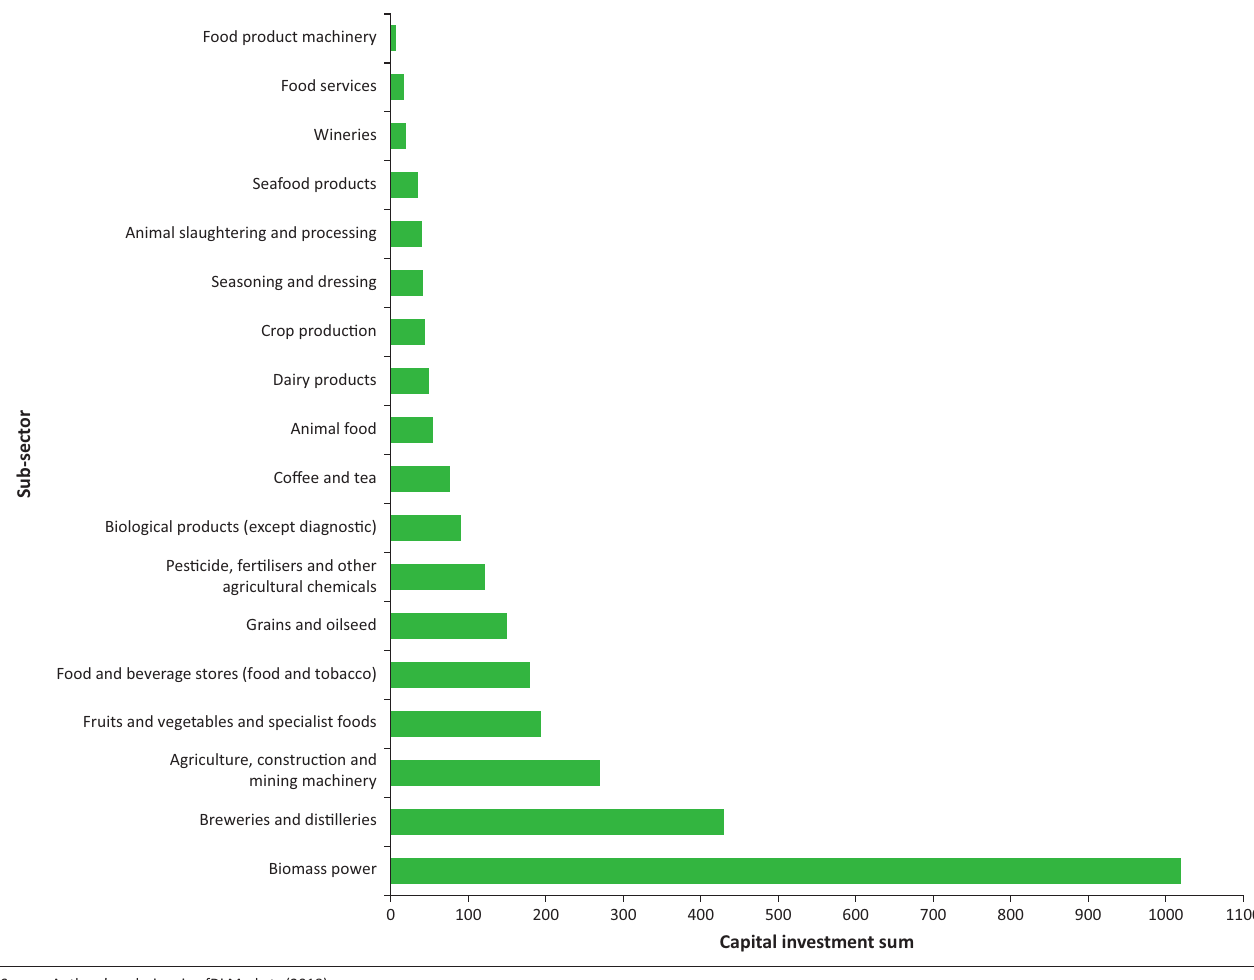
FIGURE 1: Total greenfield foreign direct investment inflows into South Africa by sub-sector, 2003–2014 (US$,